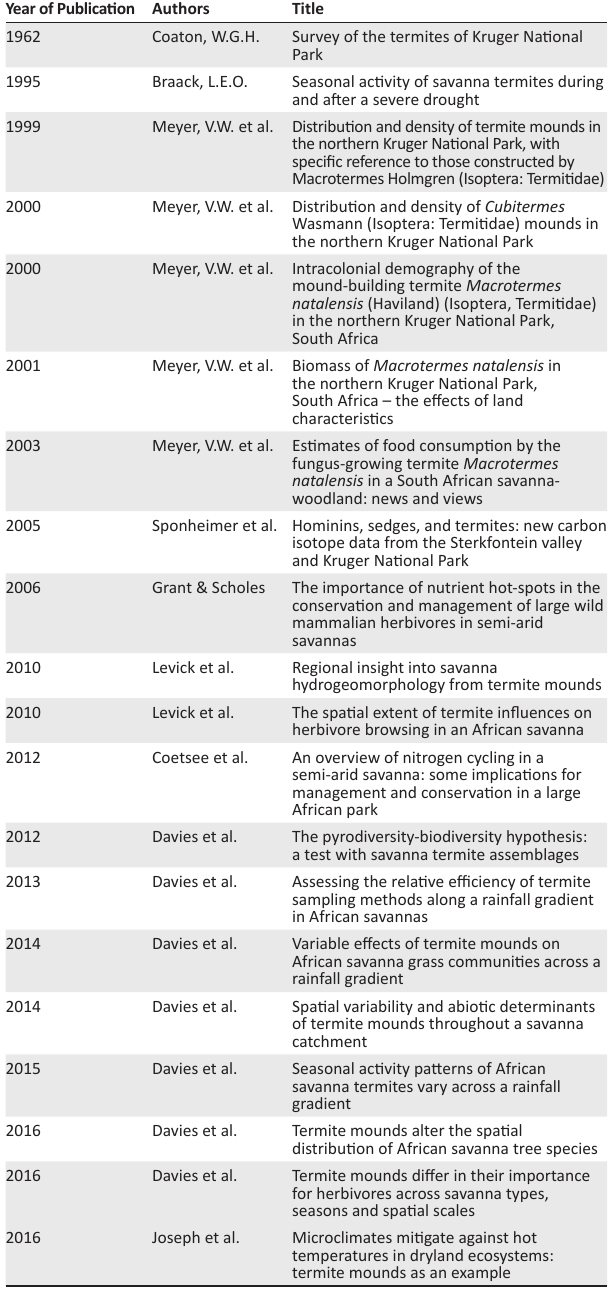
TABLE 1: History of published, termite-focused research conducted in the Kruger National Park, South